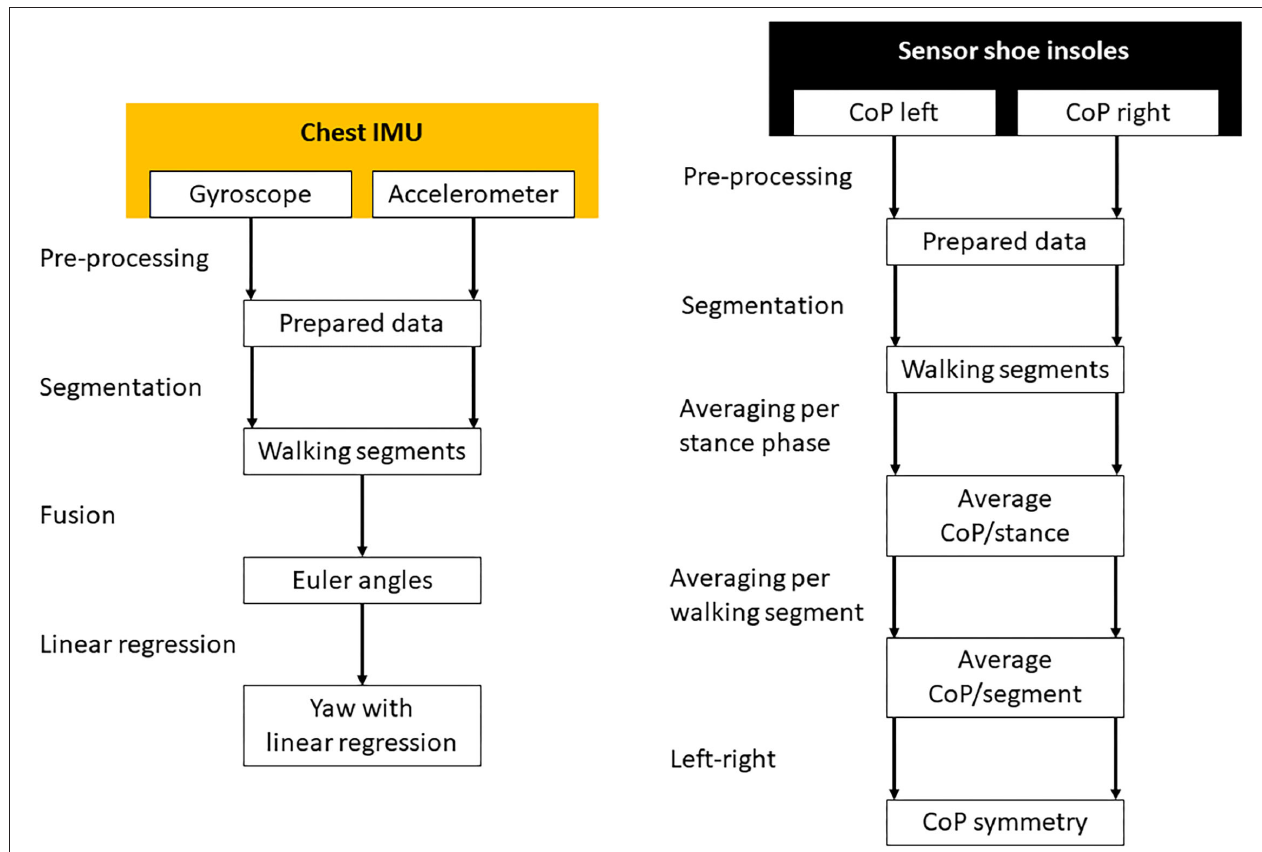
FIGURE 3 | The signal processing of the chest inertial measurement unit (left) and the sensory shoe insoles (right). Missing data was interpolated and both sensor systems were synchronized during the pre-processing phase. The measurements were separated in time to different WS. Gyroscope and accelerometer data were fused to calculate Euler angles in three-dimensional space. In the resulting yaw signal, linear regressions were calculated for every WS separately. The CoP of each leg was averaged for every stance phase of each step. Afterward the CoP was averaged for every WS separately and the difference between the left and right foot